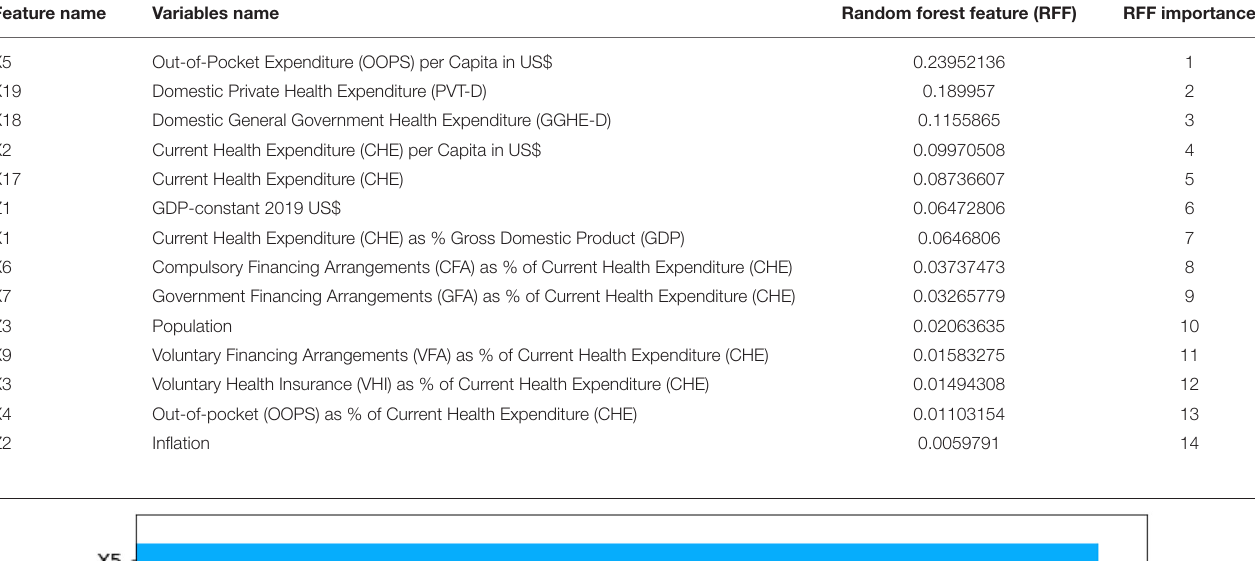
TABLE 2 | Basic Random Forest-Based feature importance for UHC coverage covering all the three blocks.